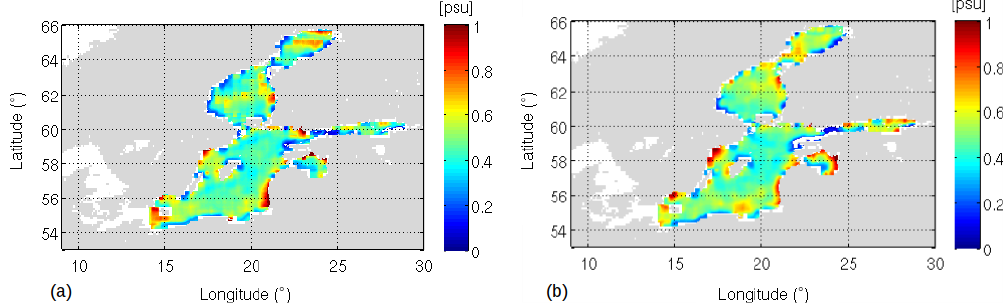
Figure 11. Error standard deviations computed by CTC for Baltic+ L4 SSS during the (a) cold season and (b) warm season.